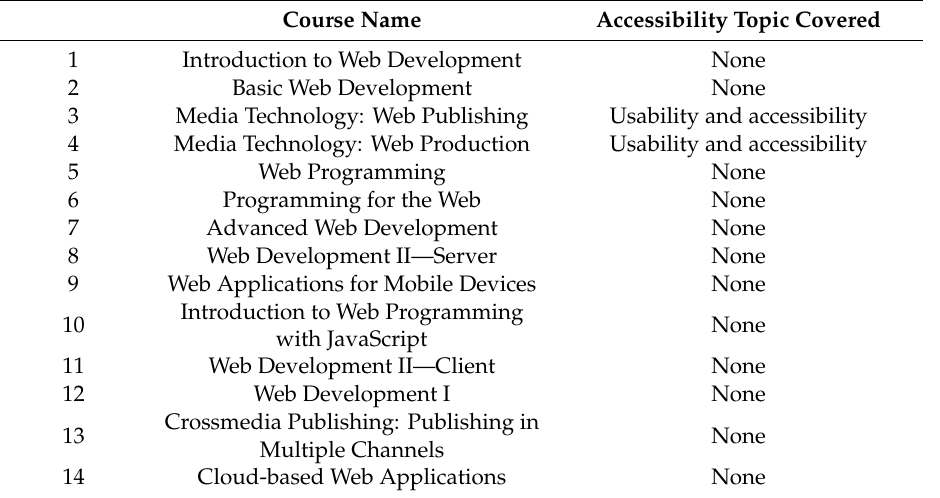
Table 1. Web development courses that were analyzed in relation to accessibility.